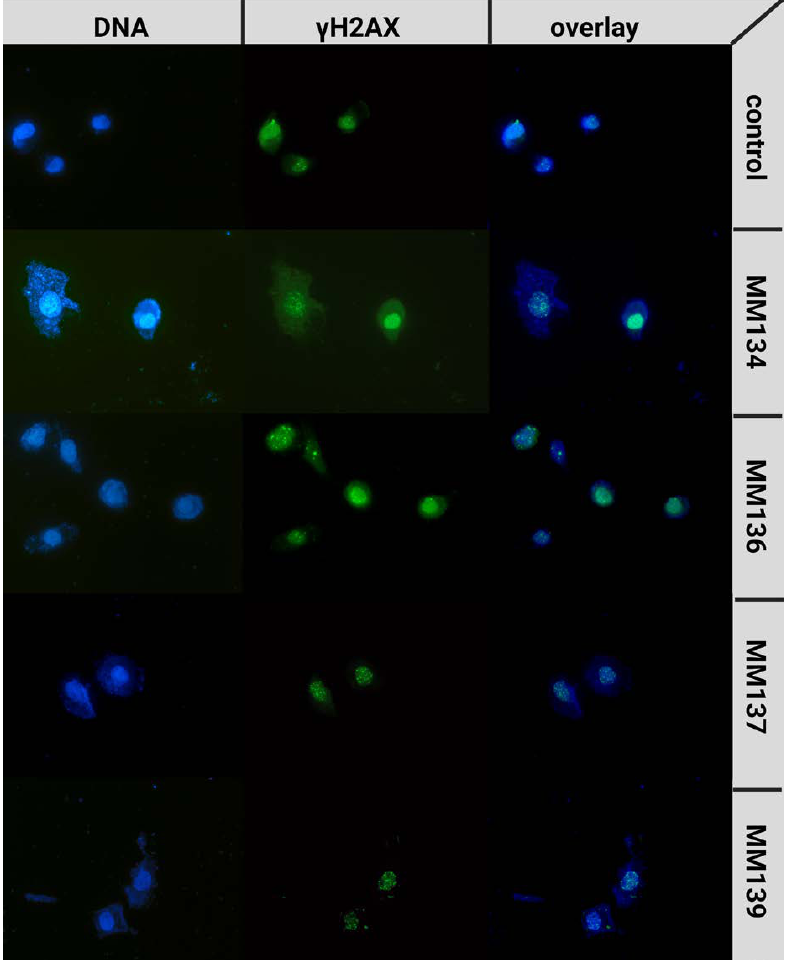
Figure 11. Examples of γ - H2AX stained cells: PC-3 cells were treated with MM134 , -6 , -7 , and -9 in concentrations concerning their IC 50 values. Images are shown in magnification of 40×.